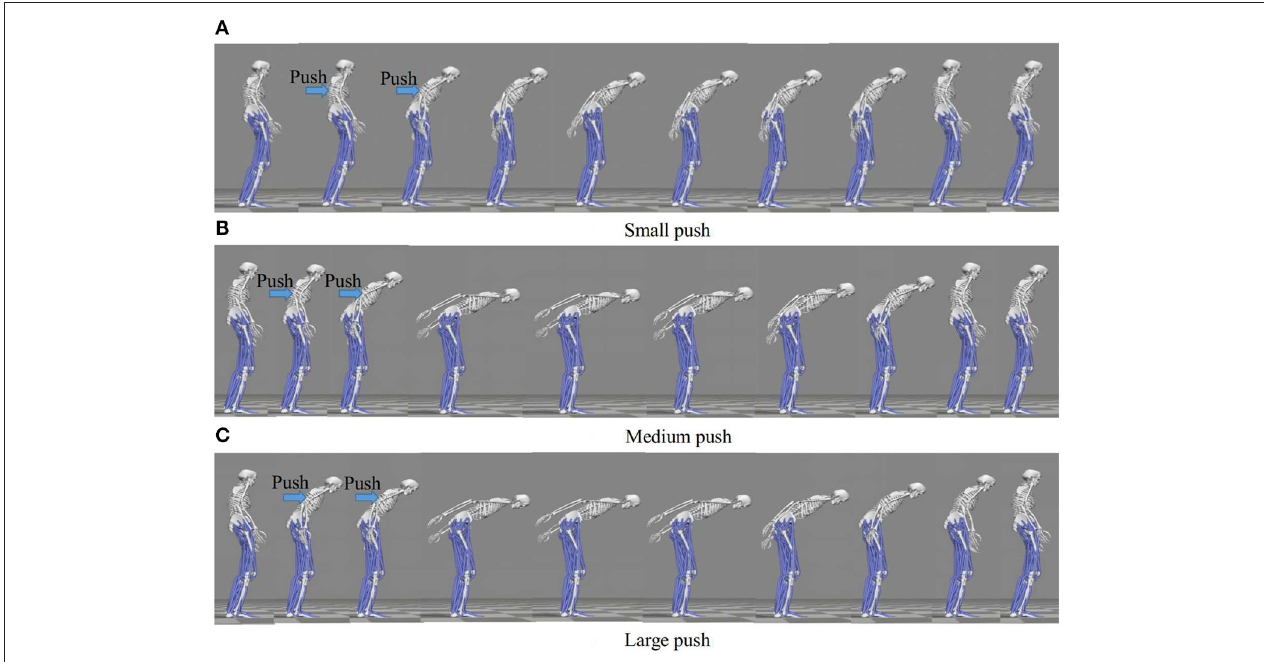
FIGURE 13 | Balance recovery motion of Subject 1 for three different magnitudes of push: ( a ) Small push, ( b ) Medium push, and ( c ) Large push. As the push force increases, more arm usage can be recruited to improve the balance maintenance ability. And, anti-phase exits between arm and hip joint angles, indicating the active arm rotations for balance control